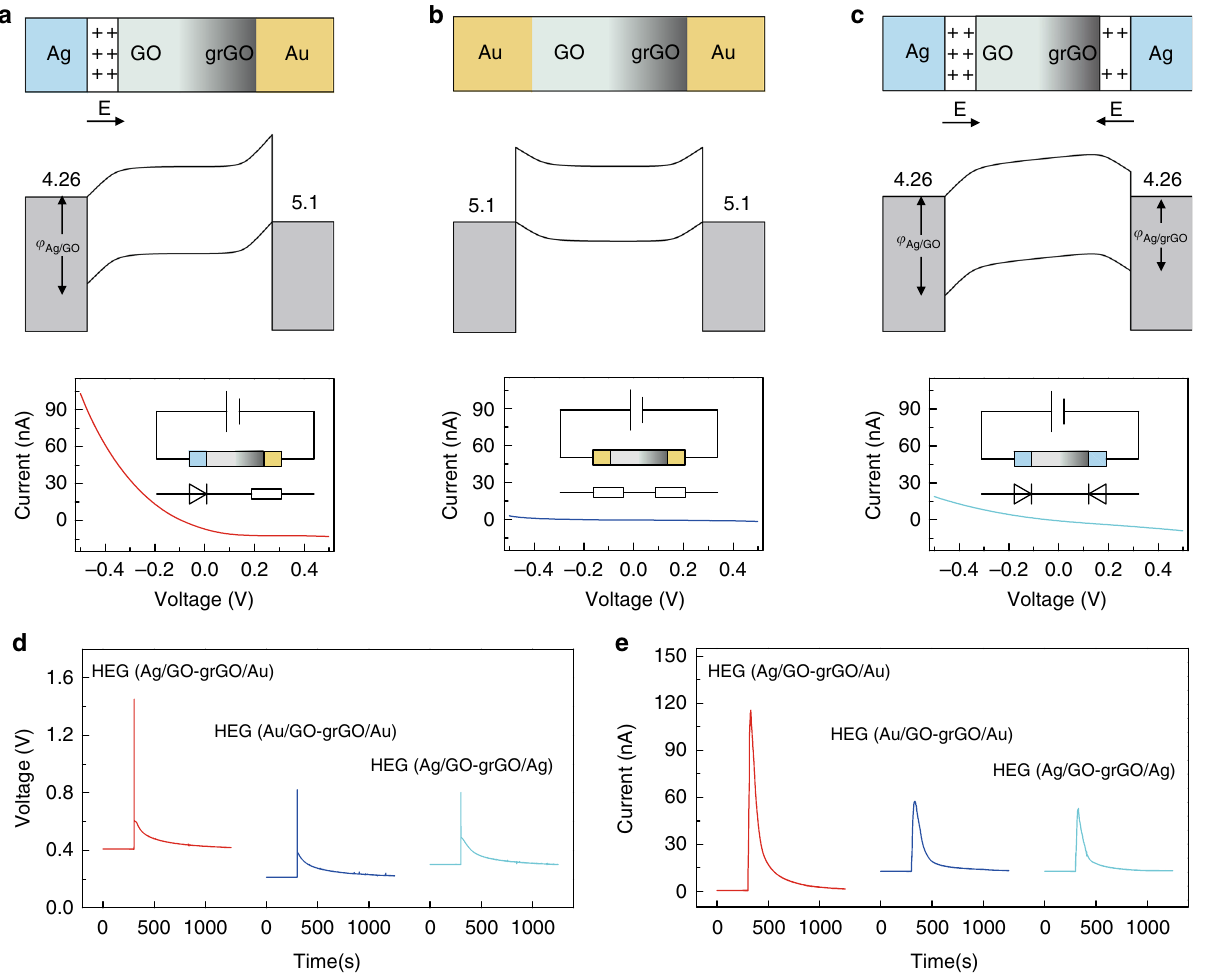
Fig. 4 Comparison of hygroelectric generators with different con fi gurations. a – c Device structure (top), energy band diagram (middle), and corresponding current – voltage characteristic curve (bottom) of ( a ) HEG (Ag/GO – grGO/Au) with a pair of Ag and Au electrodes, ( b ) HEG (Au/GO – grGO/Au) with two identical Au electrodes and ( c ) HEG (Ag/GO – grGO/Ag) with two identical Ag electrodes. The sandwiched heterogeneous graphene oxide (h-GO) between two metal electrodes is composed of graphene oxide (GO) and gradient reduced graphene oxide (grGO) parts. φ indicates the barrier potential difference at the interface. Current – voltage curves show typical Schottky diode characteristic of HEG (Ag/GO – grGO/Au), Ohmic contact of HEG (Au/ GO – grGO/Au) and two opposite Schottky contact of HEG (Ag/GO – grGO/Ag). The inset of current – voltage curve is the corresponding test circuit and equivalent circuit diagram. d , e Voltage and current output of above three hygroelectric generators with different device con fi